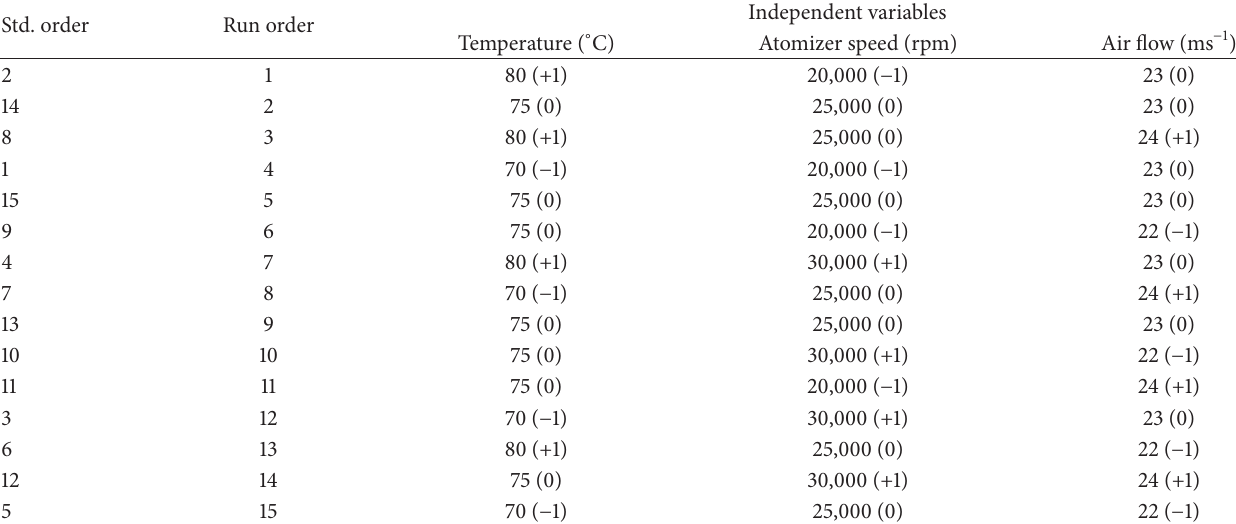
Table 1: Box-Behnken experimental